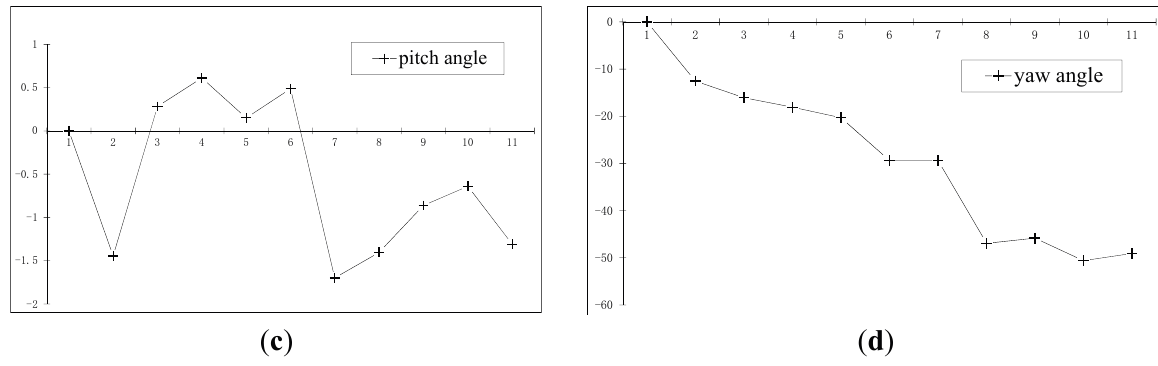
Figure 12. The recovery of the moving car. ( a ) The trajectory reconstruction results of two moving points on the car in the XY plane; ( b ) Those in the Z direction; ( c ) The measurement results of the pitch angle of the car; ( d ) The measurement results of the yaw angle of the